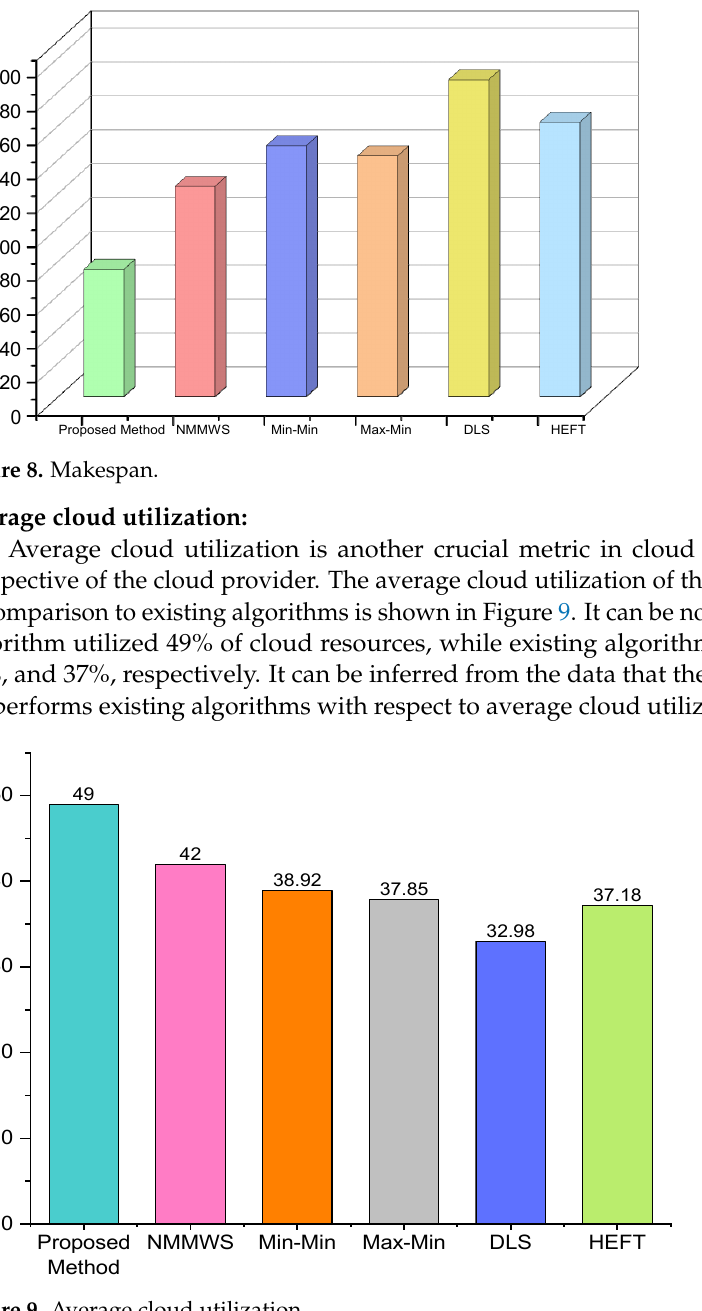
Figure 10. Cost. VM Actual Working time: In our proposed work, the actual working time of virtual machines for the given tasks is 130 ms for VM1, 100 ms for VM2, 234 ms for VM3, and 256 ms for VM4, as shown in Figure 11.